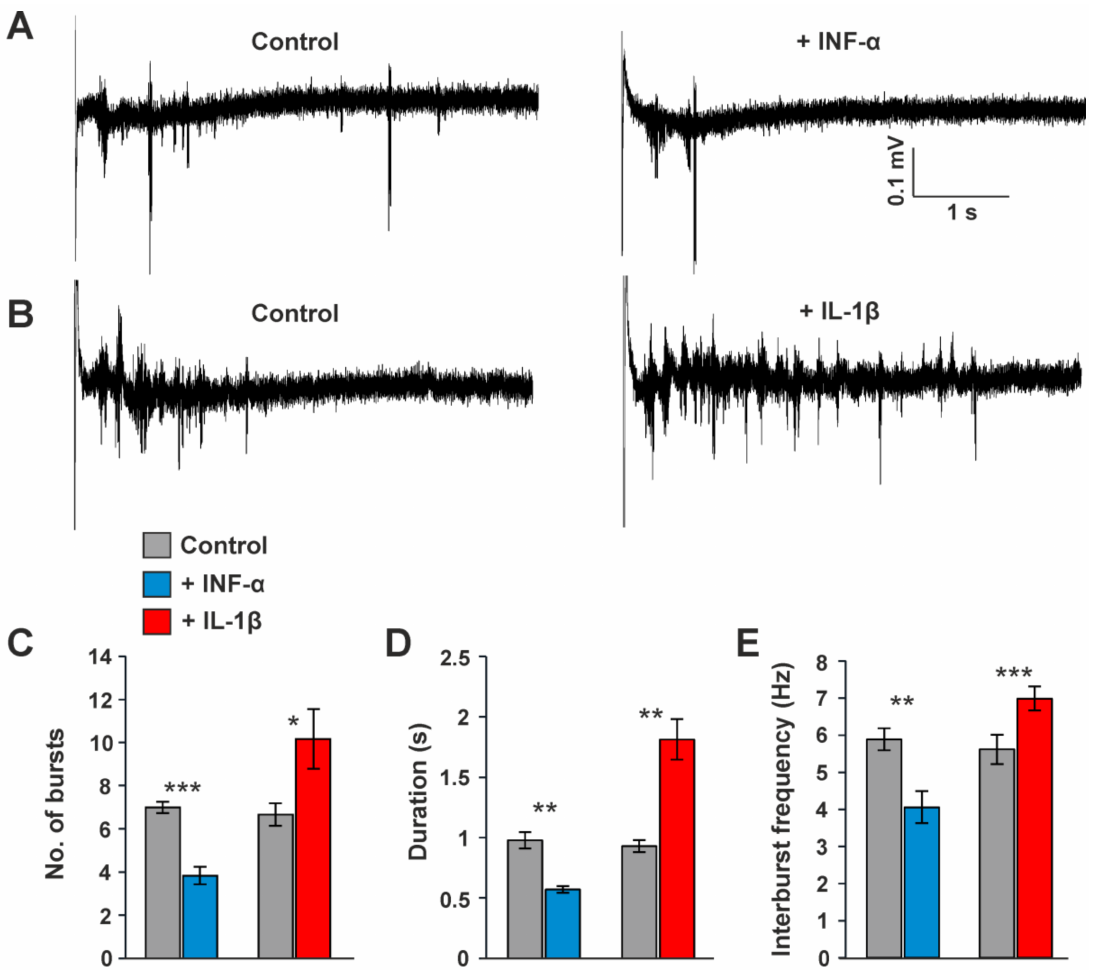
Figure 10. The effects of cytokines on intrathalamic burst activity in C57BL/6J mice. ( A , B ) Extra- cellular field potential recordings displaying the changes in burst activity in VB after application of IFN- α ( A ) and IL-1 β ( B ) evoked by stimulating the IC. ( C , D ) The bar graphs showing the changes in number of bursts ( C ), their duration ( D ), and the interburst frequency ( E ) of oscillatory burst activity by inflammatory cytokines. *, **, and *** indicate p values less than 0.05, 0.01, and 0.001, respectively. These findings indicate that IFN- α and IL-1 β differentially modulate intrathalamic